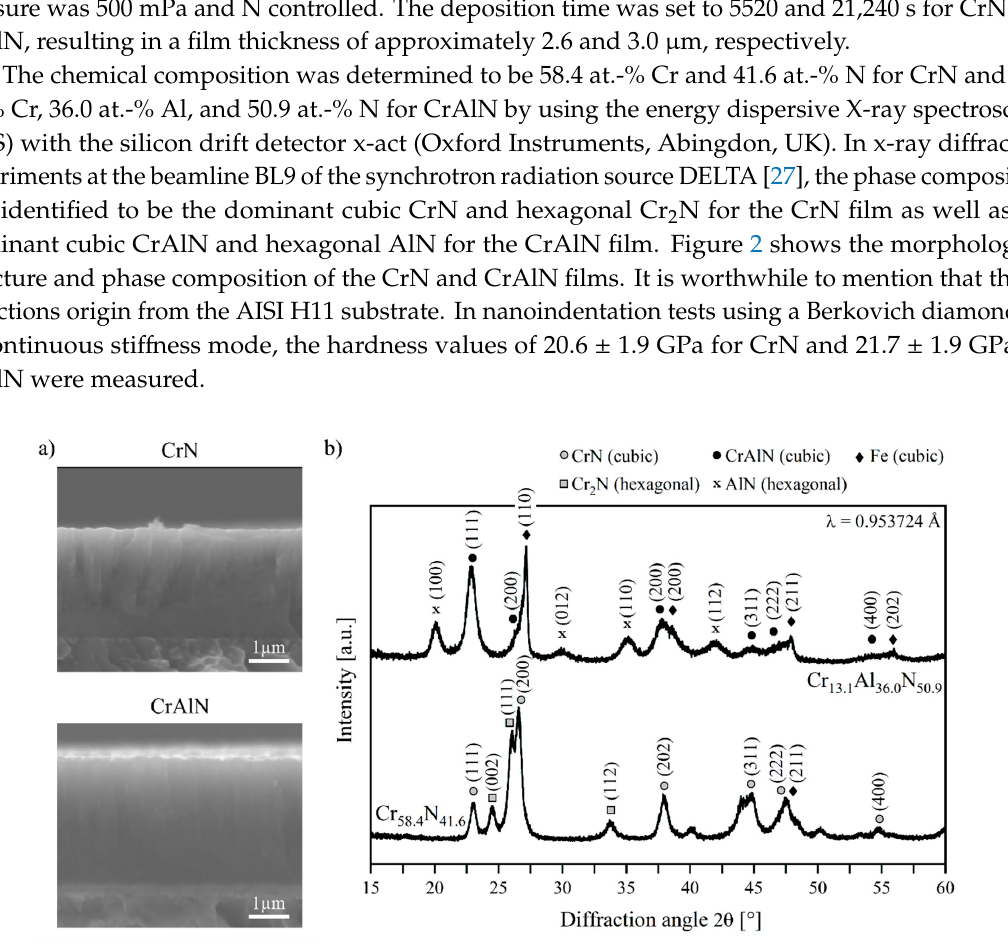
Figure 2. SEM micrographs of the ( a ) morphological structure and ( b ) XRD pattern of the CrN and CrAlN films.